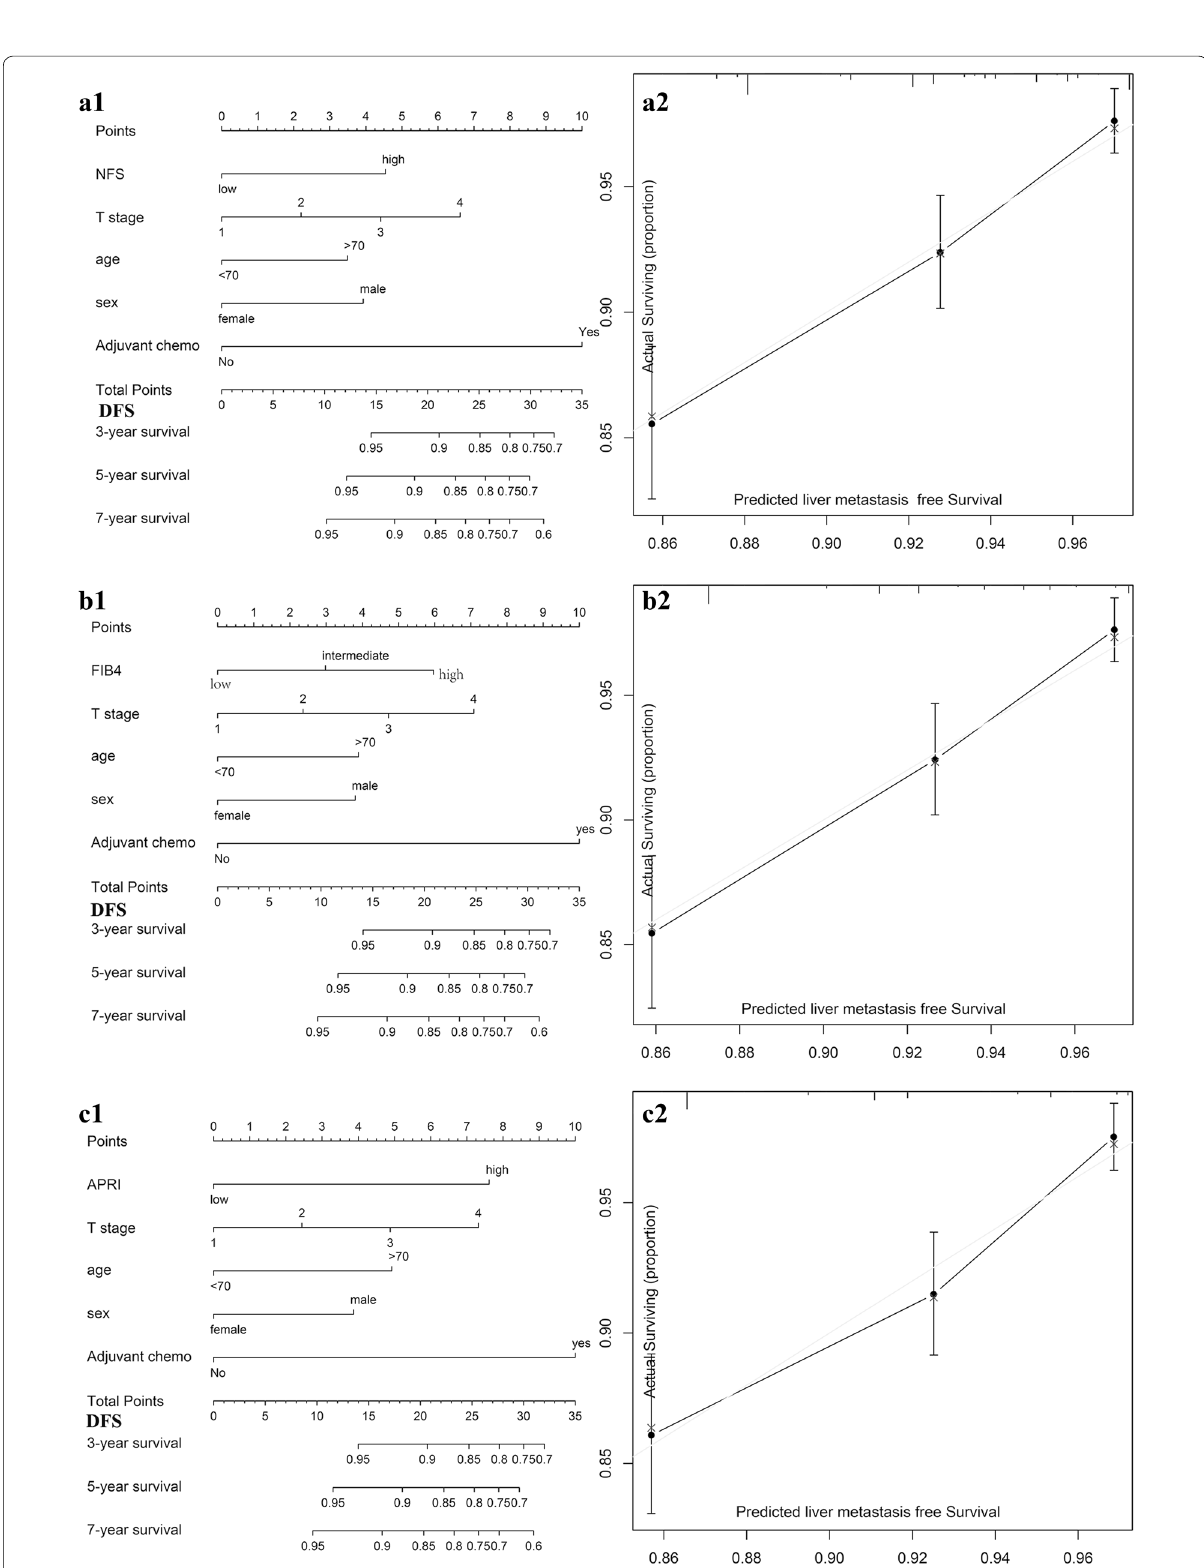
Fig. 3 Construction of liver fibrosis score nomogram to estimate hepatic DFS in the discovery cohort, along with the assessment of the model calibration. a1 NFS nomogram, a2 Calibration curves for NFS. b1 FIB4 nomogram, b2 Calibration curves for FIB4; c1 APRI nomogram, c2 Calibration curves for